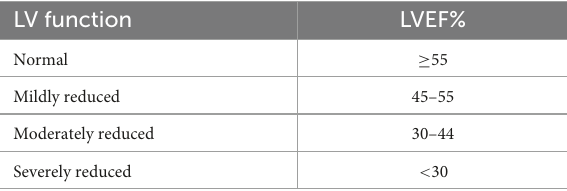
TABLE 1 Reference value and grading scale for the